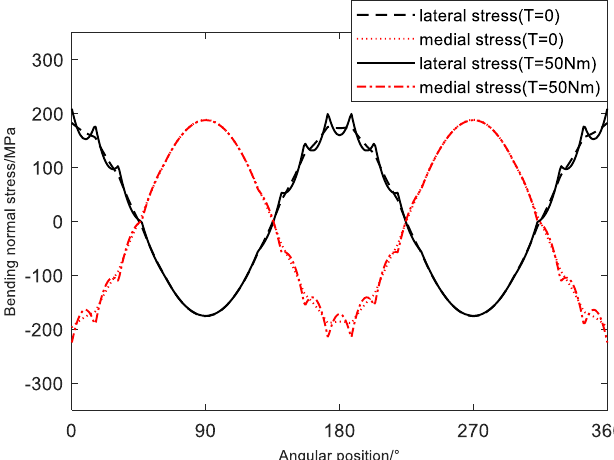
Fig. 13. Bending normal stress distribution of outer ring of the